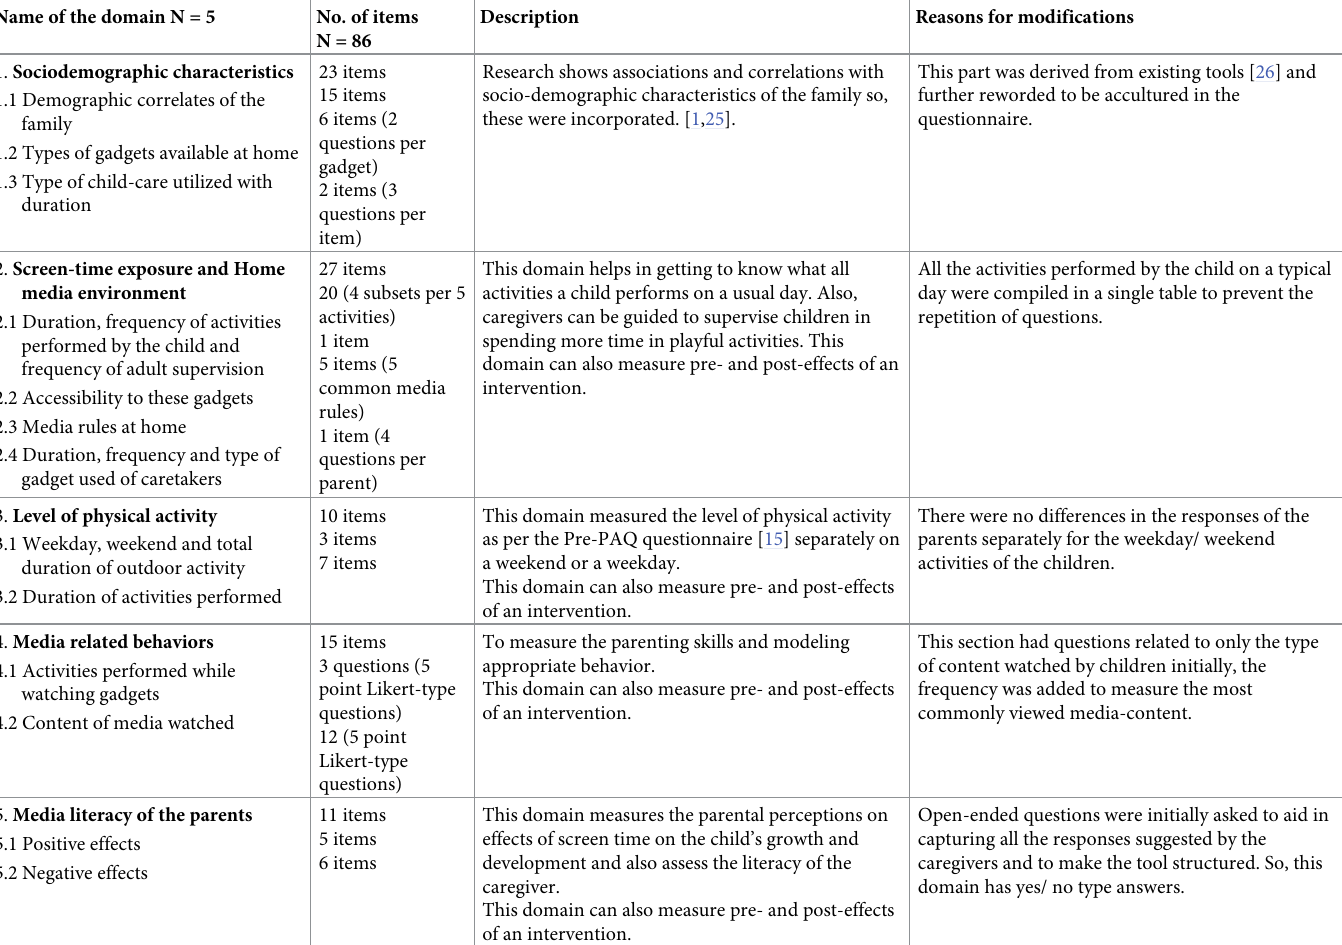
Table 1. Description of the digital screen exposure questionnaire (DSEQ) items and constructs. Name of the domain N =